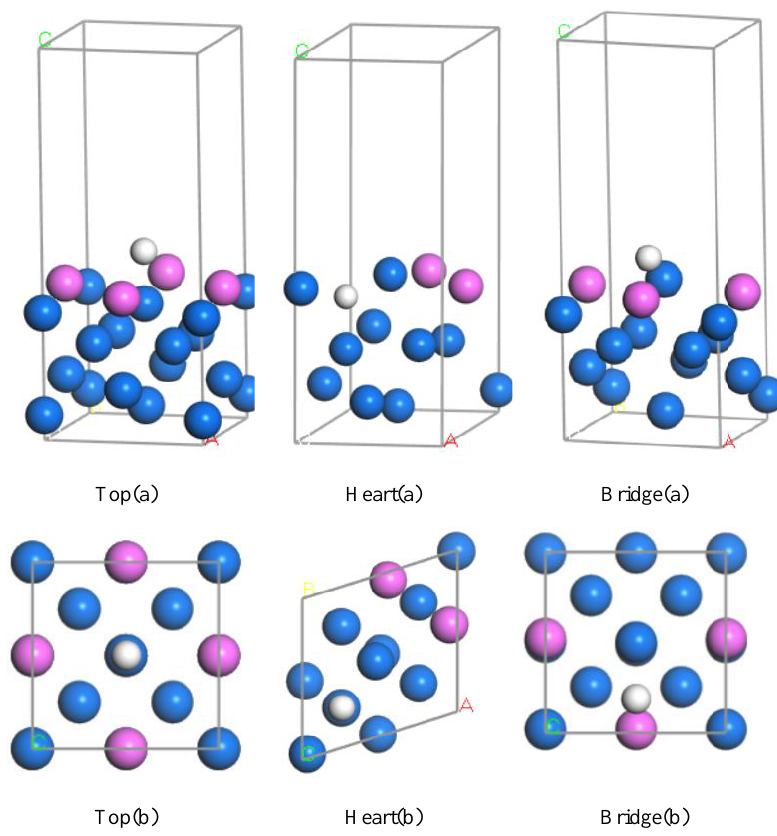
Figure 6. Model of H atom adsorbed Plutonium-Aluminum system after structure optimization ( a is oblique view, b is top view). Table 1. Surface energy of each doping